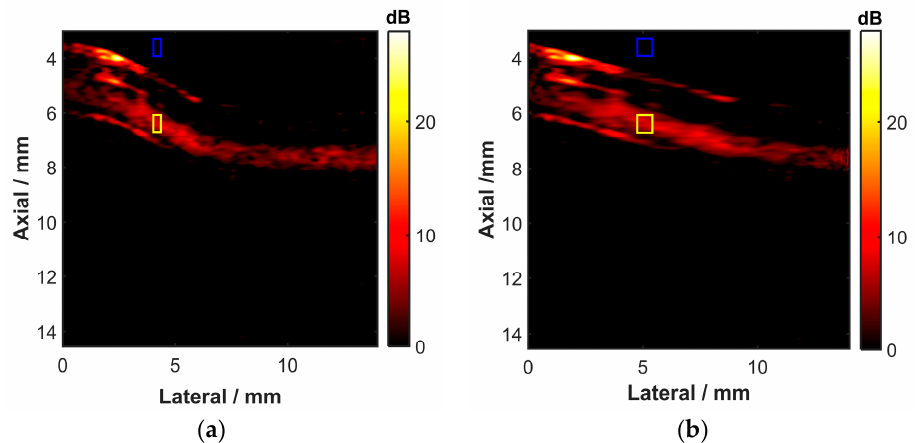
Figure 15. Flow image information calculated with power Doppler: ( a ) original image without motion compensation and ( b ) the compensated image. The blood flow area (yellow rectangular area) and the clutter area (blue rectangular area) were used to calculate the CNR.